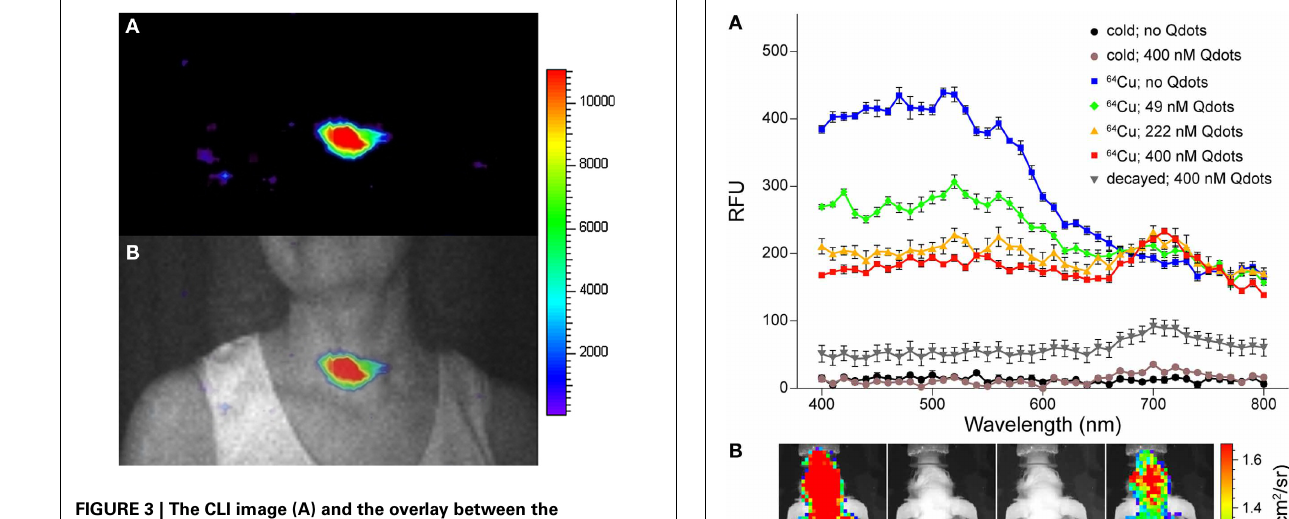
FIGURE 3 | The CLI image (A) and the overlay between the photographic image (gray color) and the CLI image (colorful) (B) of the human thyroid. (Adapted with the permission of Liu et al. [65]).